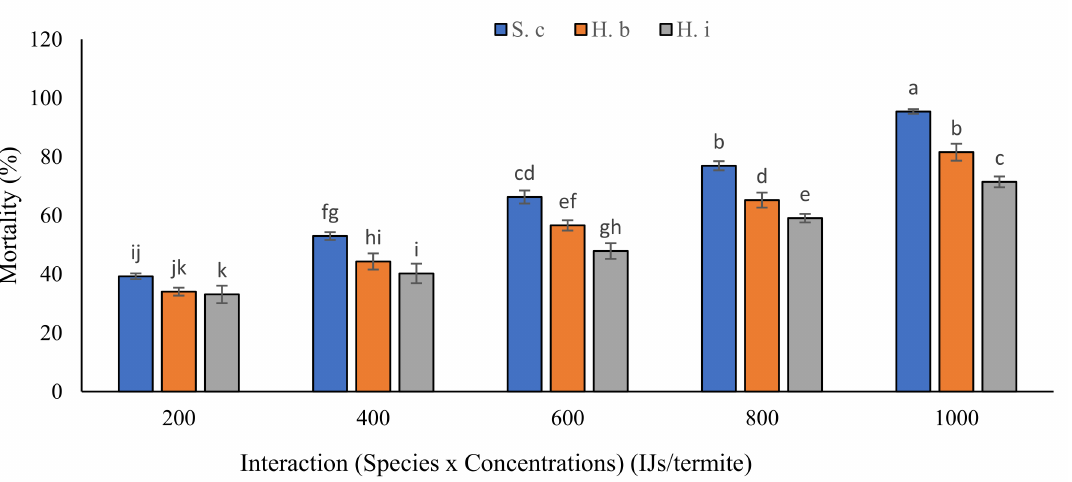
Figure 5. Interactive effect of nematode species × nematode concentrations (S × C) on percentage mortality of Odontotermes obesus workers kept under laboratory conditions (26 ± 1 ◦ C). Bars with different lowercase letters were significantly different at p ≤ 0.05 (LSD test). Vertical bars indicate standard error (SE) values. S. c: Steinernema carpocapsae; H. b: Heterorhabditis bacteriophora; and H. i: Heterorhabditis indica